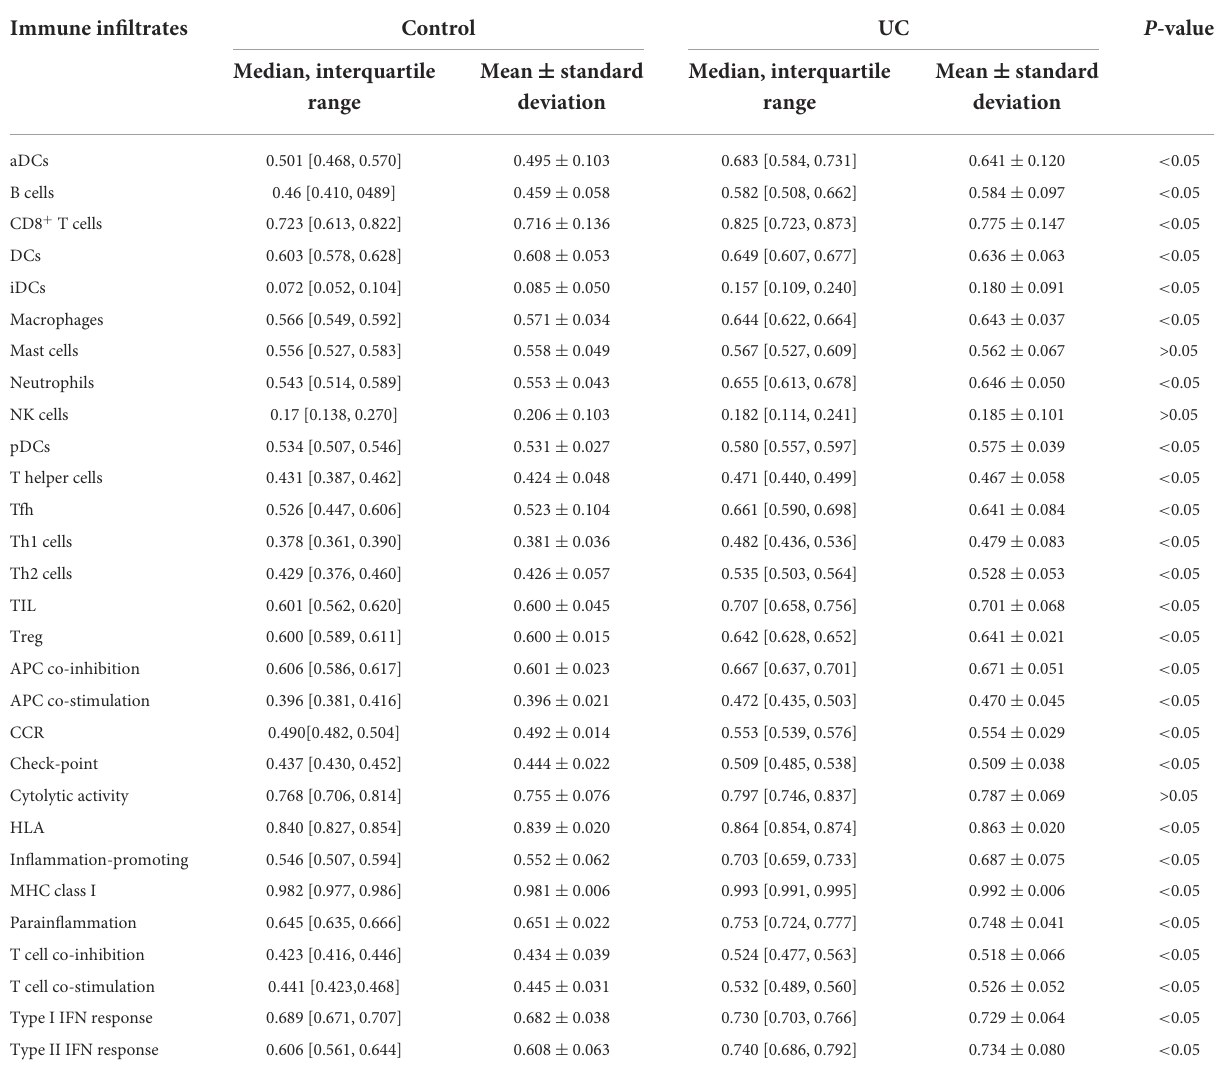
TABLE 3 Results of immune infiltration